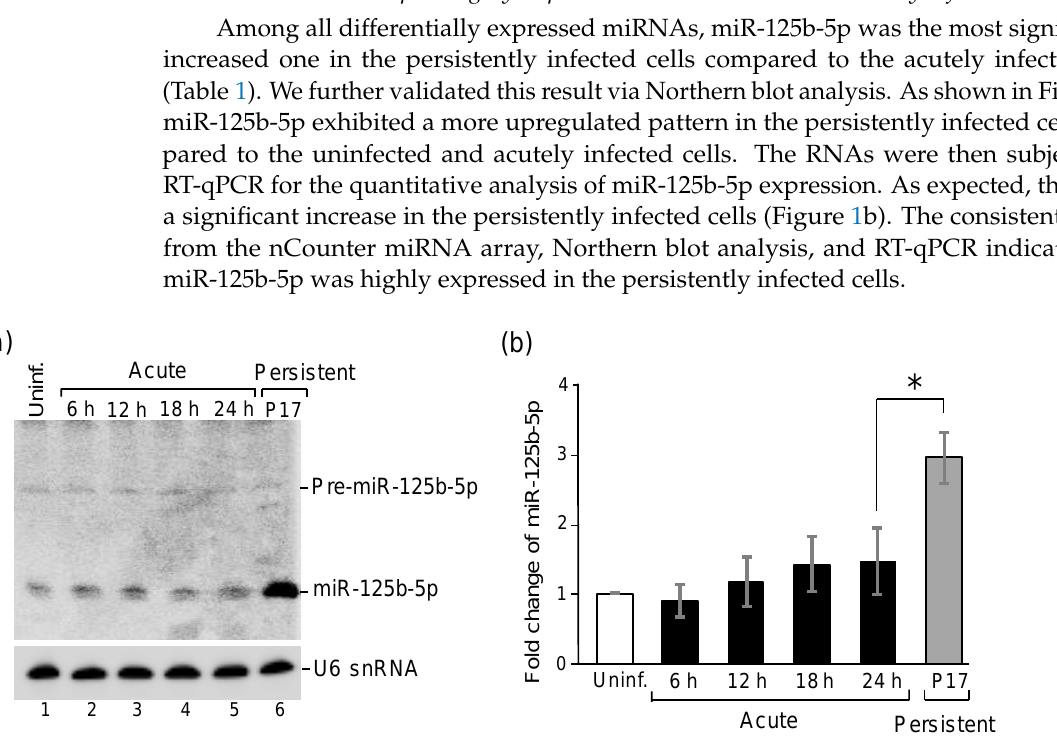
(A.) measured at 24 h post infection compared to mock infection. 2 . The cells that survived acute infection were passaged every 5 days. The RNA was extracted at the 17th passage and subjected to RT-qPCR. Values represent the fold change (log 2 ) of significantly up- or down-regulated miRNAs in cells persistently infected with JEV (P.) compared to the mock- infected cells. 3 . Upregulation is defined as an expression level of miRNA of more than or equal to 2 folds detected in the persistent JEV infection in comparison with acute JEV infection. 4 . Downregulation is defined as an expression level of miRNA of less than 2 folds detected in the persistent JEV infection in comparison to the acute JEV infection.